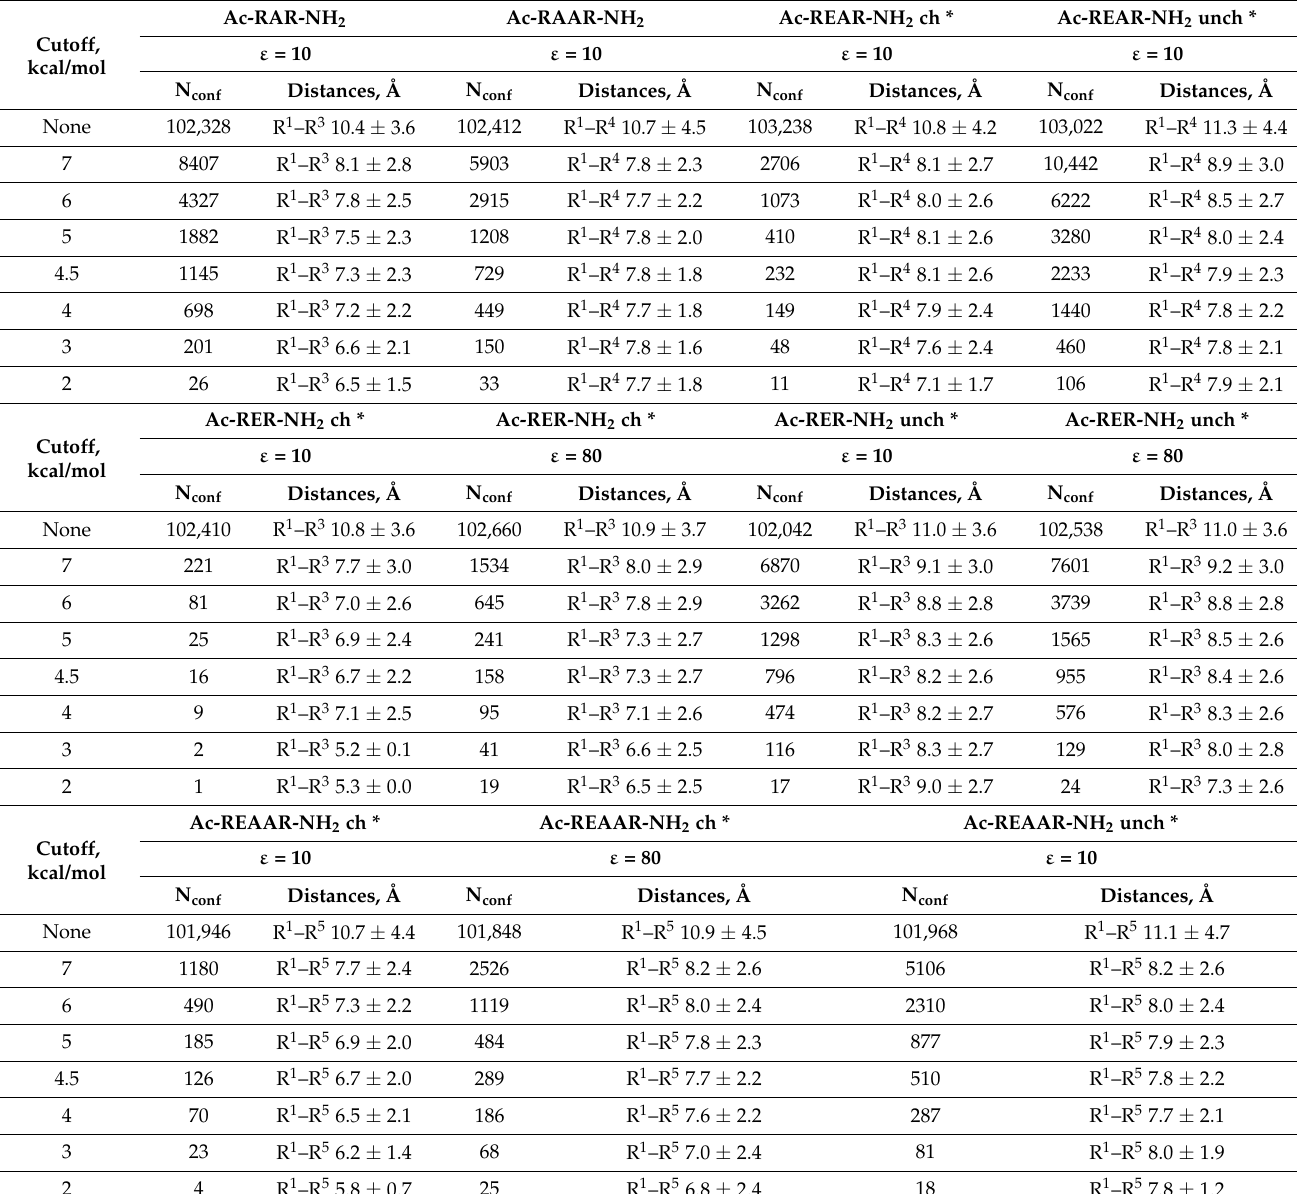
Table 1. Average distances between the guanidinium groups in the molecules of arginine-containing short peptides containing two arginine